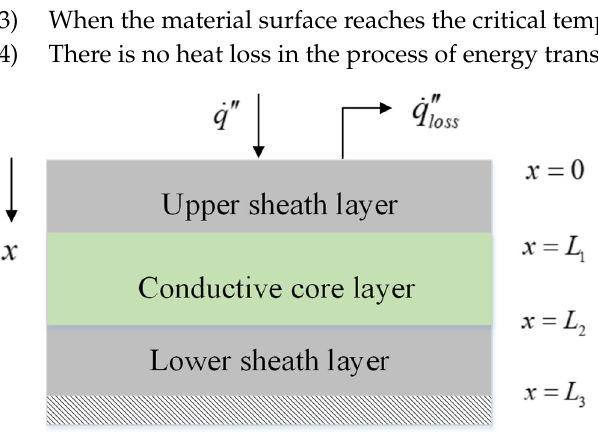
9 of 15 Figure 6. Comparison of HRR curves of XLPE cables under different radiation intensities. 3.4. Establishment of Cable Ignition Model Based on Heat Conduction For the cable test sample using a cone calorimeter, the side and bottom of the sample are basically in an adiabatic state because the back and side are wrapped with a layer of glass fiber cloth with low thermal conductivity. Aluminum foil is coated on the outside of the glass fiber cloth to reduce the thermal radiation on the side, so that only the twisted surface of the cable test sample is exposed to the external radiant heat source. Therefore, it can be simplified to a one-dimensional heat transfer problem. The initial temperature of the cable test sample is the ambient temperature. Under the radiation of external heat source, the surface temperature of the cable sample increases with time, and there is con- vective heat loss and radiant heat loss on the upper surface of cable. This problem is a one-